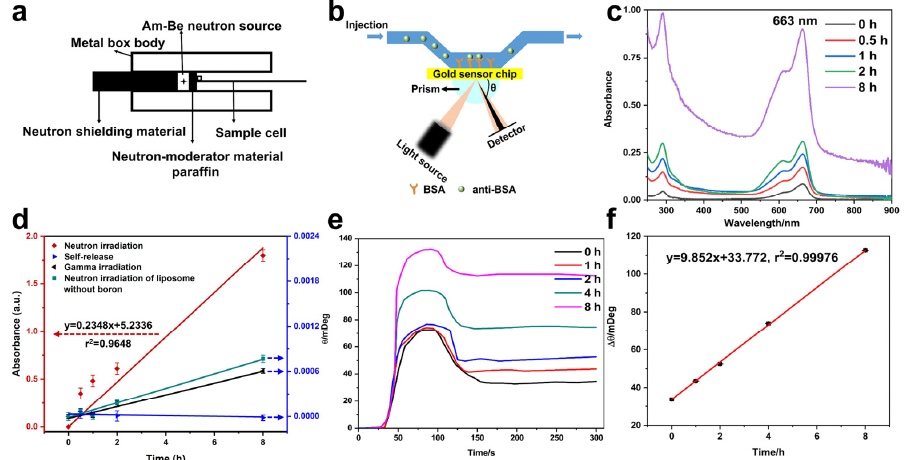
Figure 10. Release detection after irradiation, schematic diagram of radiation device ( a ), schematic diagram of SPR detection ( b ), absorbance peak of released MB from composite liposome by neutron irradiation (the samples have been diluted twice) ( c ), absorbance analysis of different samples after irradiation ( d ), the resonance angle signal detected by SPR of released anti-BSA ( e ), and the linear correlation of anti-BSA resonance with irradiation time ( f ).